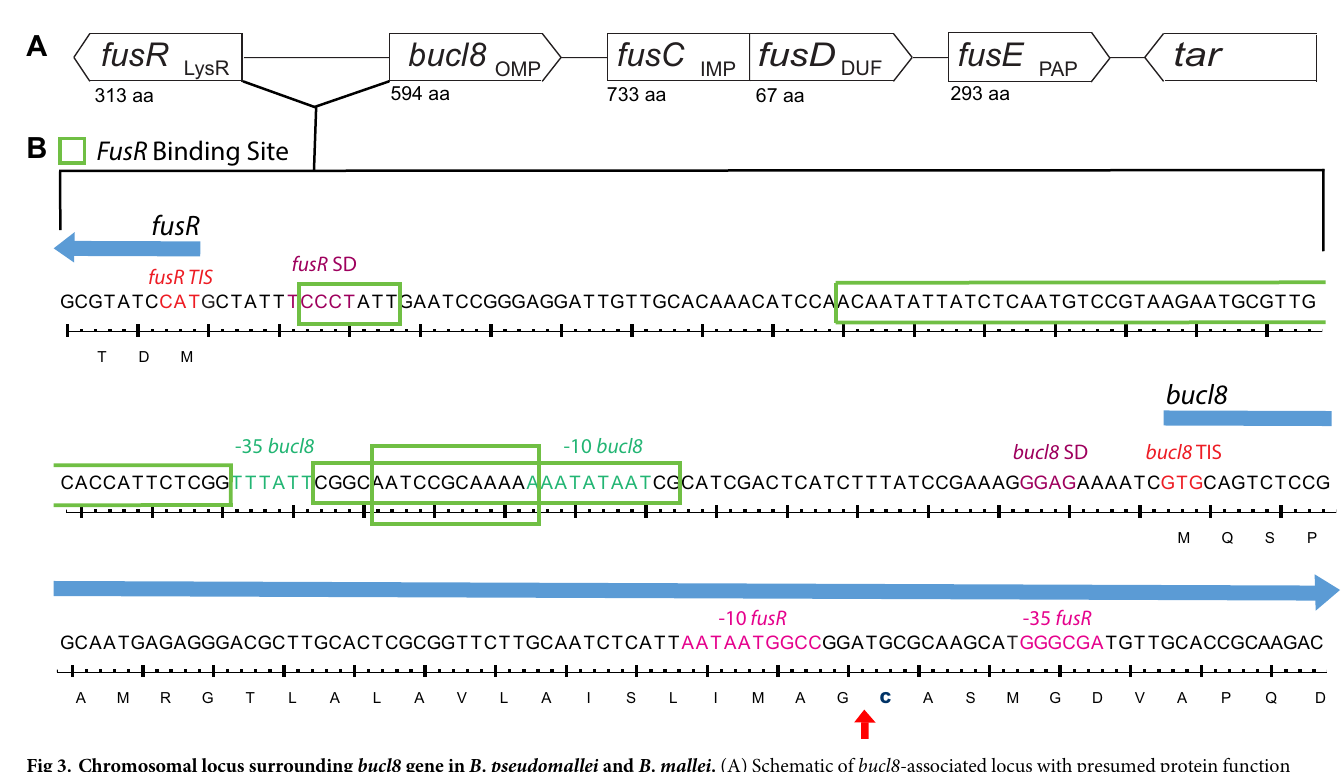
Fig 3. Chromosomal locus surrounding bucl8 gene in B . pseudomallei and B . mallei . (A) Schematic of bucl8 -associated locus with presumed protein function (subscript) and amino acid length (aa). Upstream of bucl8 is gene fusR , while downstream are genes fusCD and fusE . Flanking the bucl8 operon is unrelated downstream gene tar . LysR, LysR-type transcriptional regulator; OMP, Outer membrane protein; IMP, Inner membrane protein; DUF, Domain of unknown function; and PAP, periplasmic adaptor protein. (B) Regulatory intergenic region between fusR and bucl8 . Both nucleotide and translated sequence are shown. Red arrow indicates cleavage site between the signal peptide and N-terminal cysteine linker (bolded).